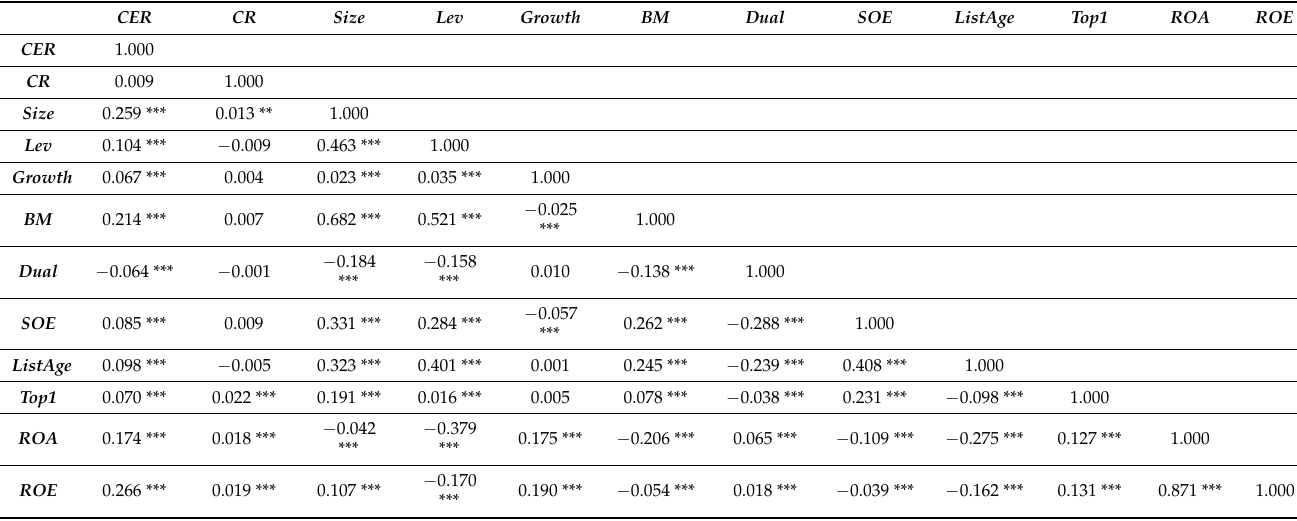
Table A1. Variables’ correlation